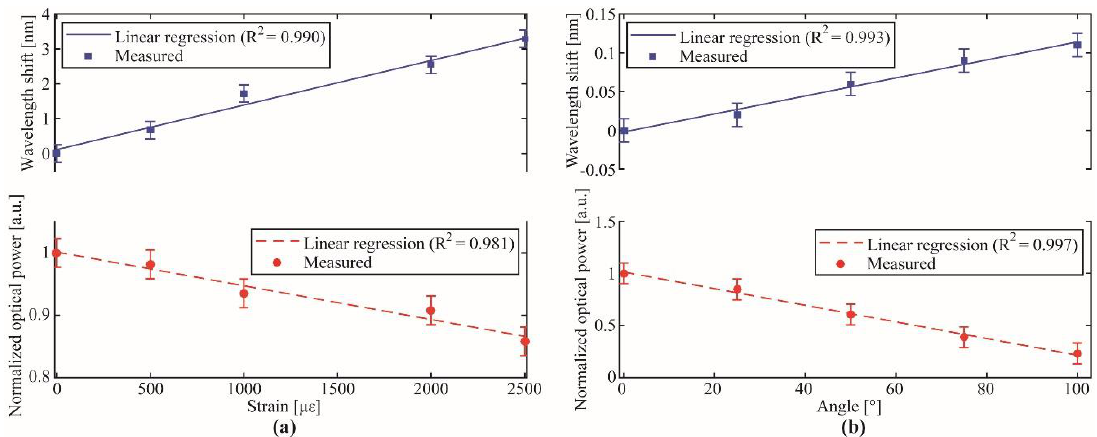
Figure 9. Characterization of the FBG-embedded smart textile for knee joint assessment: Wavelength shift and normalized optical power variation for the ( a ) strain response; ( b ) angle variation response. The error lines represent the standard deviation.